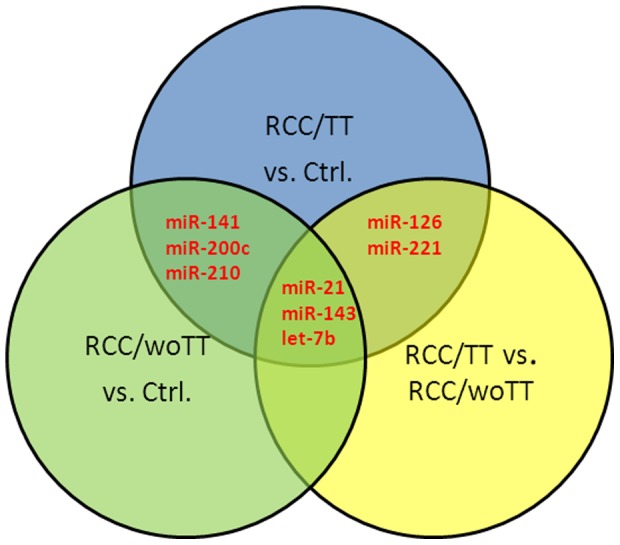
Venn diagram showing relationships between miRs that were differentially expressed in ccRCC/TT, ccRCC/woTT and non-cancerous renal tissue (ctrl).Circles include up- or down- regulated miRs for each pairwise comparison. Common miRs between different comparisons are shown in the intersections.